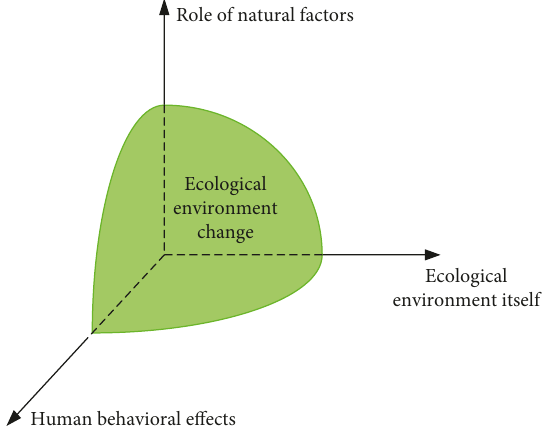
Figure 7: Structural diagram of ecological environment